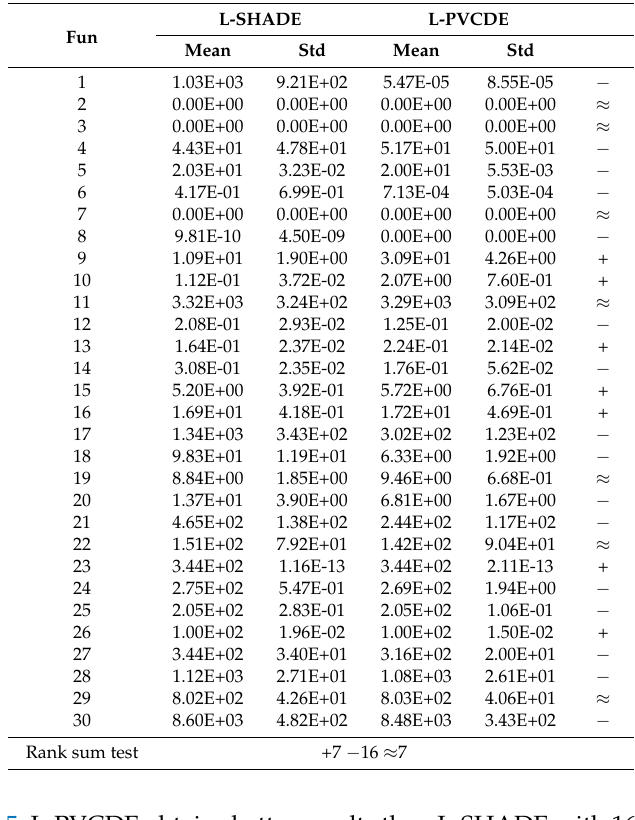
Table 5. CEC 2014 function for 50D on L-SHADE and